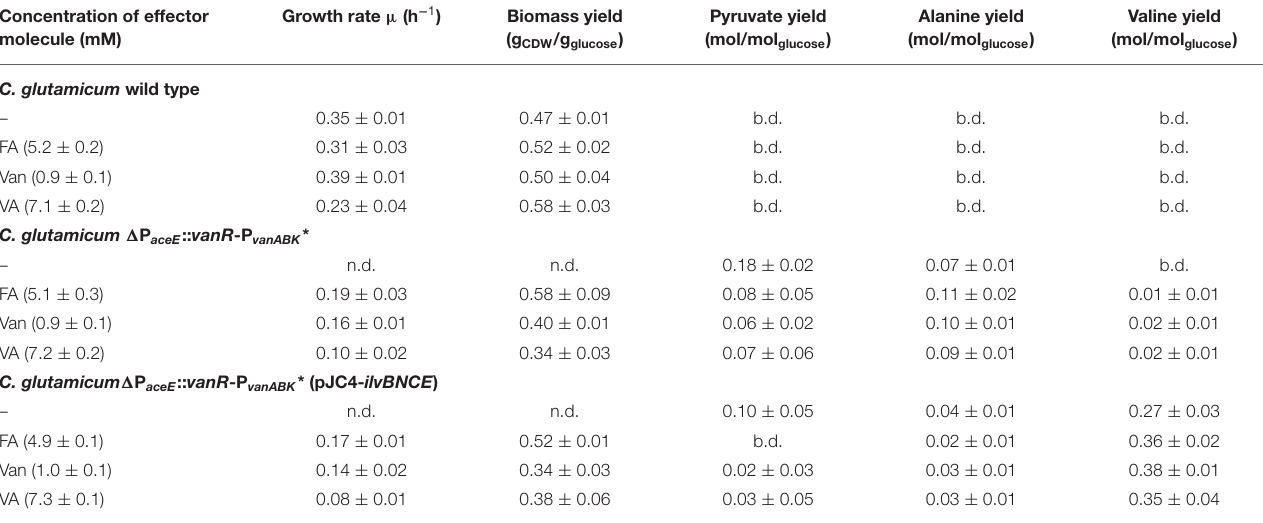
TABLE 3 | Growth rates, biomass yields, and product yields of C. glutamicum wild type, C. glutamicum 1 P aceE :: vanR -P vanABK *, and C. glutamicum 1 P aceE :: vanR -P vanABK * (pJC4- ilvBNCE ) in shaking flasks with CGXII minimal medium and 20g glucose L − 1 without and with ferulic acid, vanillin, or vanillic acid. Standard deviation was determined via cultivations of at least three biological replicates. Concentration of effector molecule